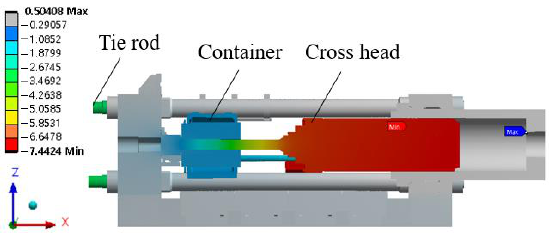
Figure 5. Total deformation of the X-axis.